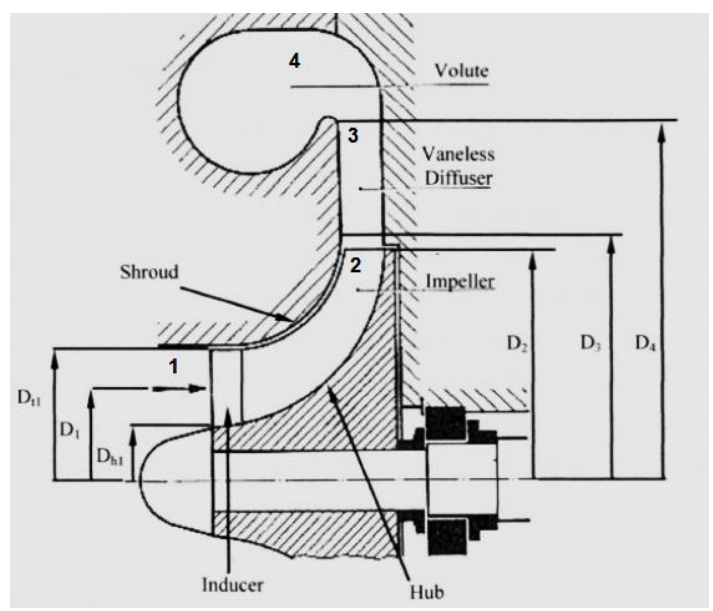
Figure 5. Centrifugal Compressor cross-section schematic labelling the stages.